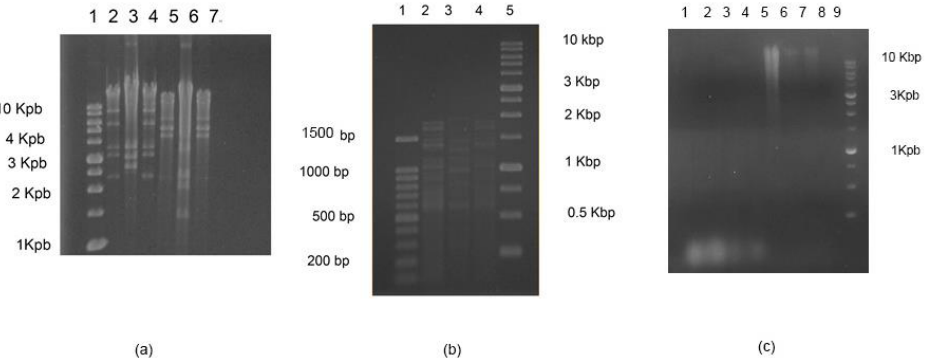
Figure 2. Genetic material of phages. ( a ) Profile of digestion with EcoRI and HindIII. Line 1: standard of molecular weight 1 kpb; line 2: DNA of phage A7 with EcoRI; line 3: DNA of phage A8 with EcoRI; line 4: DNA of phage B3 with EcoRI; line 5: DNA of phage A7 with HindIII; line 6: DNA of phage A8 with HindIII; and line 7: DNA of phage B3 with HindIII. ( b ) Profile of digestion with HinfIII. Line 1: standard of molecular weight 1 kpb; line 2: DNA of phage A7; line 3: DNA of phage A8; line 4: DNA of phage B3; and line 5: standard of molecular weight. ( c ) Digestion of genetic material with nucleases S1. Line 1: genetic material of phage A4; line 2: genetic material of phage A4; line 3: genetic material of phage A5; line 4: genetic material of phage A5; line 5: genetic material of phage A7; line 6: genetic material of phage A8; line 7: genetic material of phage B3; line 8: empty; and line 9: standard of molecular weight 1 kpb.